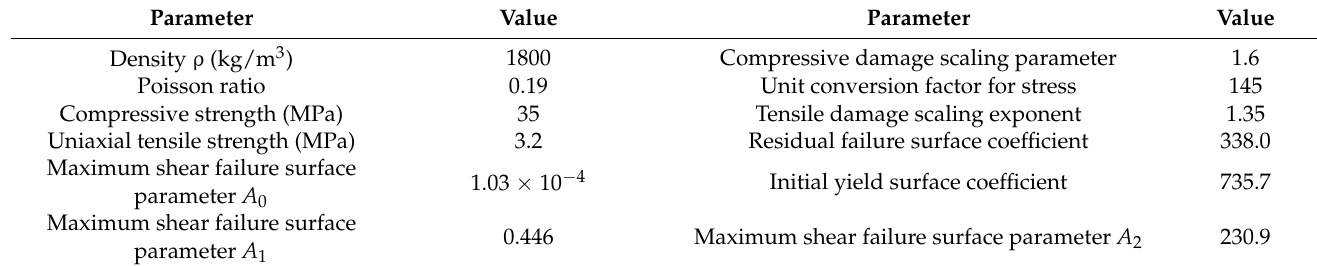
Table 2. Parameters of interfacial transition zone (ITZ).